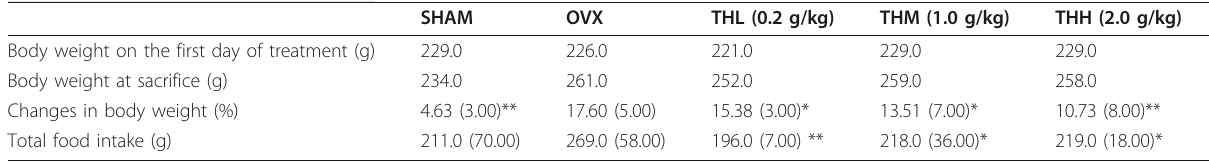
SHAM = Sham-operated Control rats; OVX = overictomised non-honey treated Control rats. THL = Tualang Honey, low dose; THM = Tualang Honey, medium dose; THH = Tualang Honey, high dose. All values are expressed as the median (IR). a Kruskal - Wallis